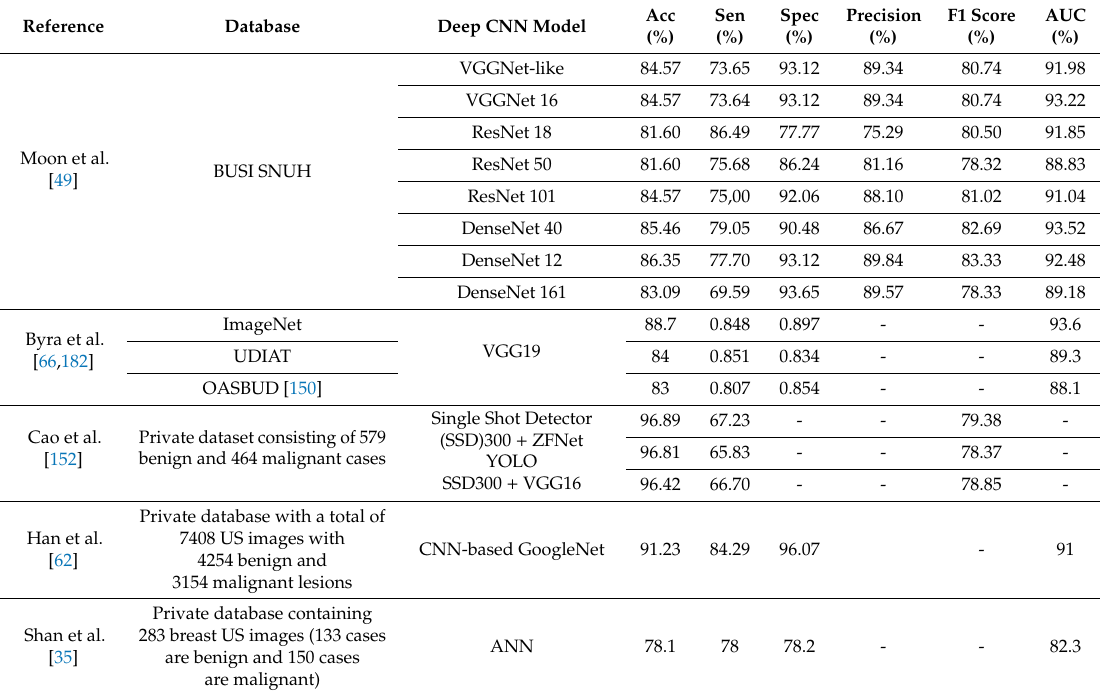
Table 7. The quantitative indicators that were used to evaluate di ff erent CNN architectures’ performances on US datasets.